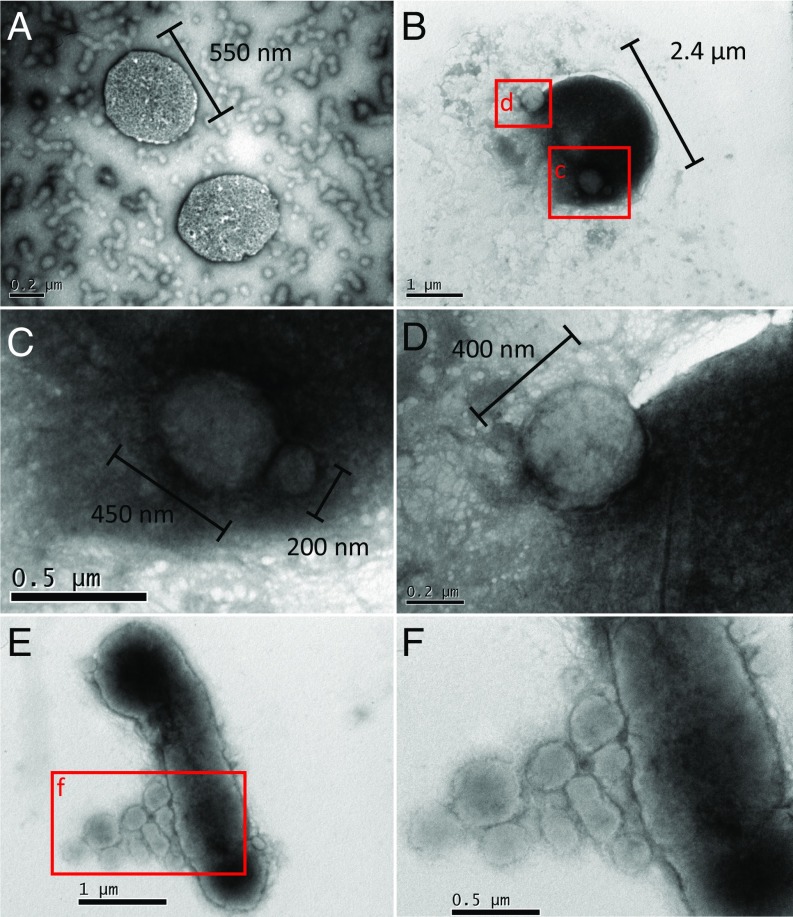
TEM of Nha-C FACS cells with Hrr. lacusprofundi ACAM34. Small individual cells consistent with being Nha-C (A). A single and “budded” cell (putative Nha-C) intimately associated with a larger cell (putative Hrr. lacusprofundi) (B–D). The budded structure may arise from cell division occurring while Nha-C cells are attached to Hrr. lacusprofundi (D). Multiple small cells (putative Nha-C) seem to be associated with a larger cell (putative Hrr. lacusprofundi) surrounded by possible extracellular material (E and F). The appearance of extracellular material occurred in other images of FACS cultures (SI Appendix, Fig. S14), including in an image of a large cell (putative Hrr. lacusprofundi) that appears to have lysed (SI Appendix, Fig. S14E).